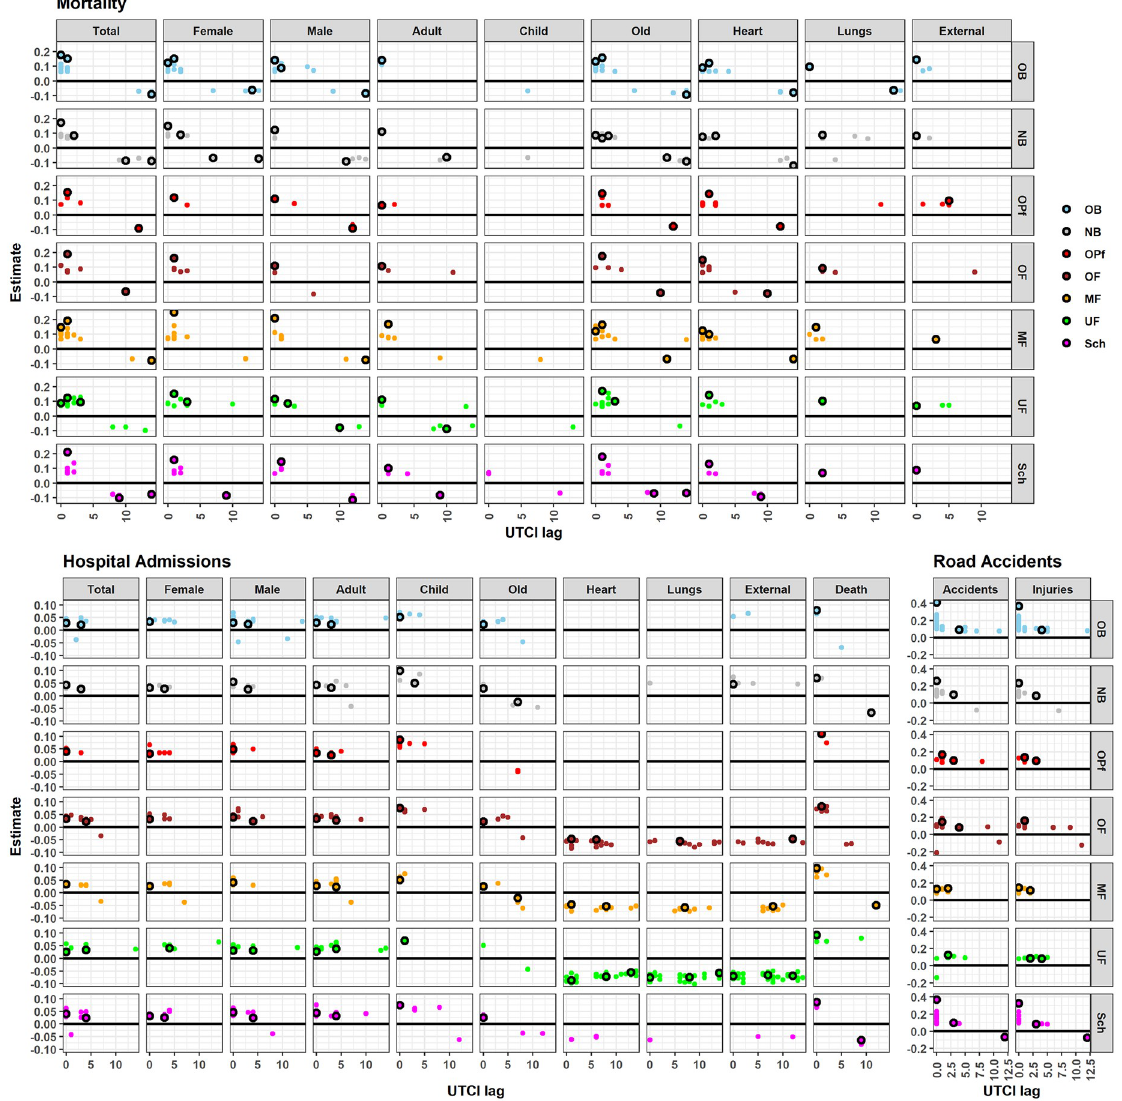
Fig 5. Summer UTCI effect. Summer UTCI effect on daily cases of mortality, hospital admissions, and road accidents for each subgroup and district. The horizontal axis represents the lag in days, and the vertical axis represents the effect estimate. It is expressed in proportion of the standard deviations of daily number of cases within the corresponding subgroup when UTCI changes by one standard deviation of its daily value. The black circles represent those effects for each region. The colored dots represent those effects for districts within the region. The absence of points indicates that the effect of UTCI was not significant for a particular lag in the corresponding